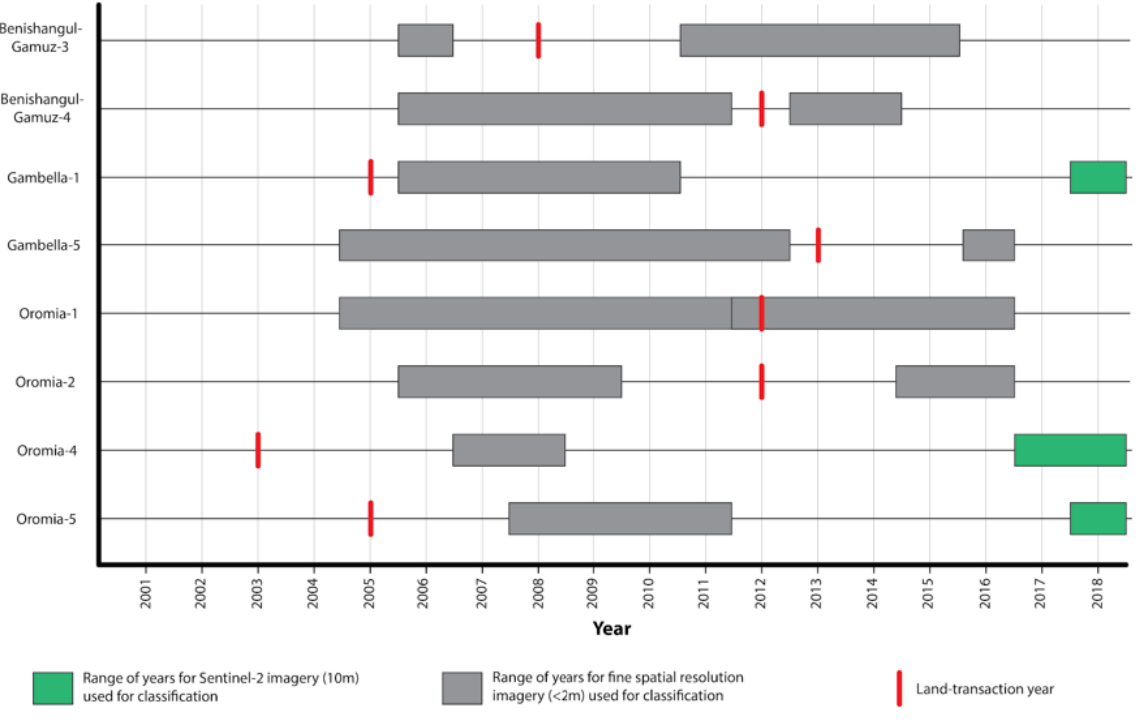
Fig. A2.1: Dates of satellite imagery in relation to the LSLT implementation